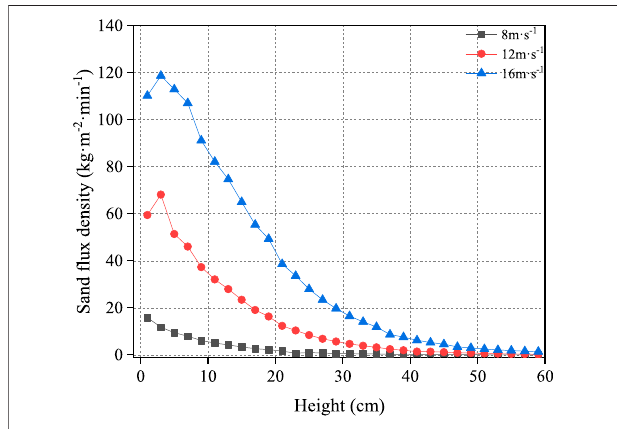
FIGURE14 | Variation law ofsand fl ux density on Gobi gravel bed under different incoming wind velocities.